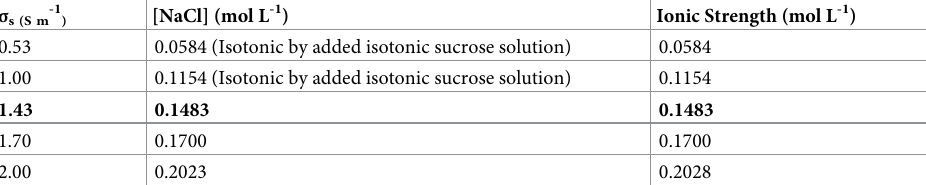
Table 1. Ionic concentrations and ionic strengths of NaCl solutions for four measured solutions measured at